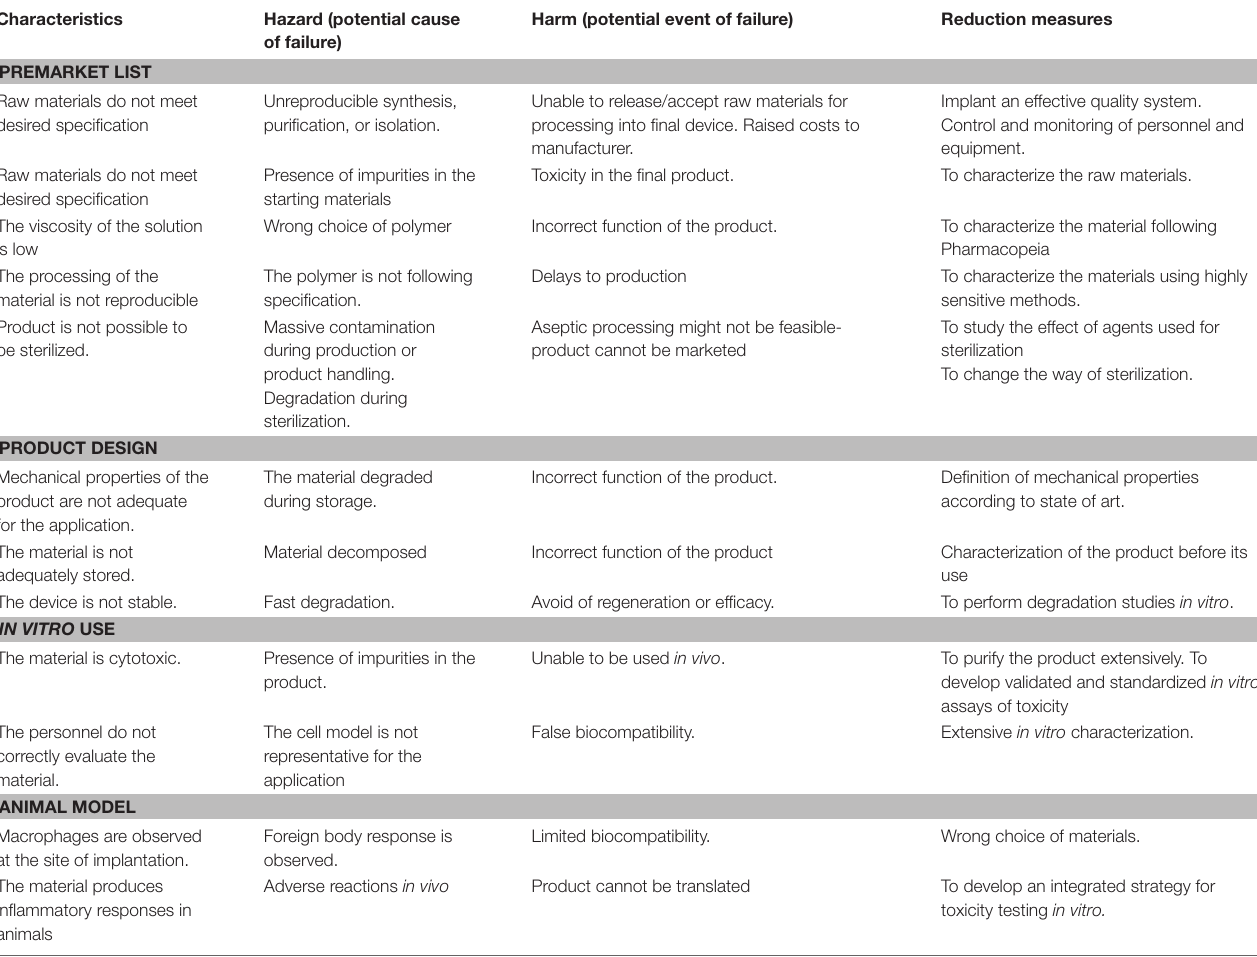
TABLE 1 | Risk assessment and evaluation toward designing a master file for a medical device product.